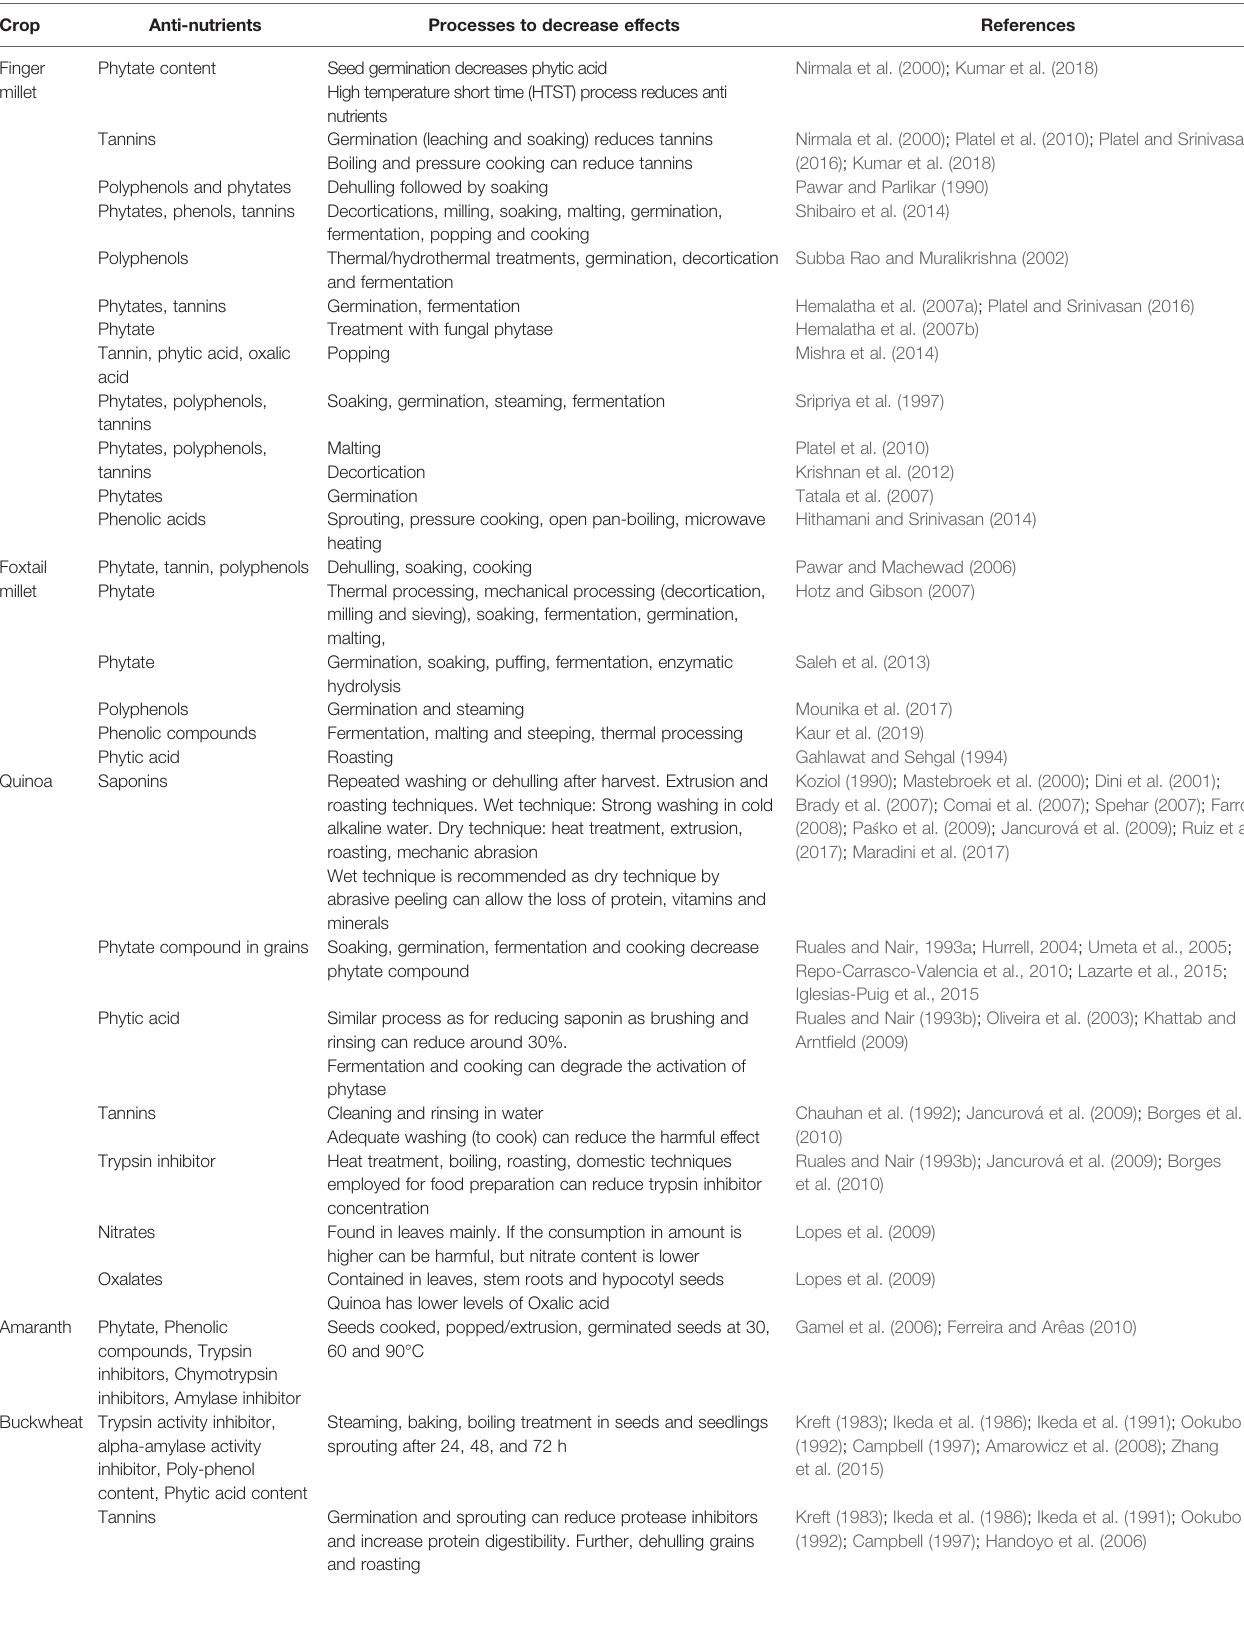
TABLE 6 | Anti-nutrients and processes to decrease anti-nutritional activity in minor-millets and pseudo-cereals.